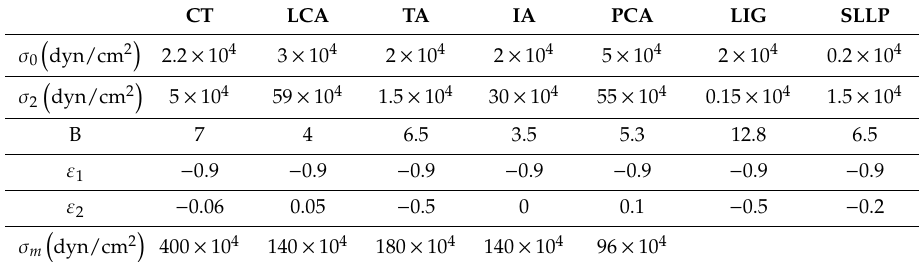
CT-cricothyroid; LCA-lateral cricothyroid; TA-thyroarytenoid; IA-interarytenoid; PCA-posterior cricoarytenoid; SLLP-superficial layer of lamina